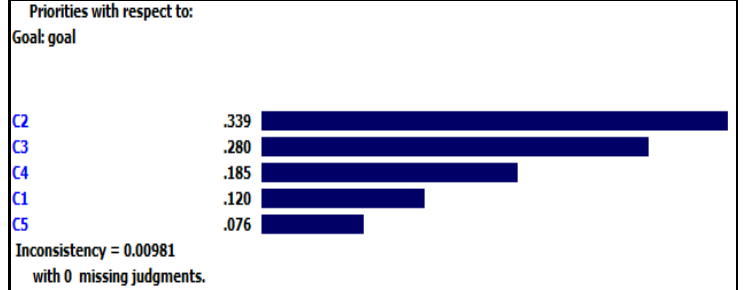
Fig. 3. Weights of the main criteria.